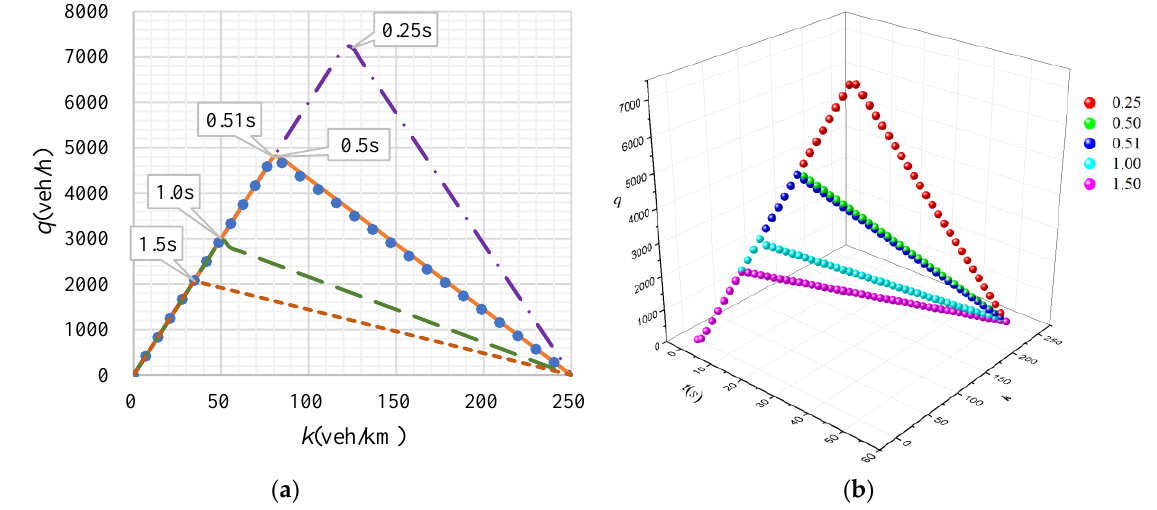
Figure 4. ( a ) Flow-density diagram for different reaction times, ( b ) time-flow-density diagram for different reaction times.